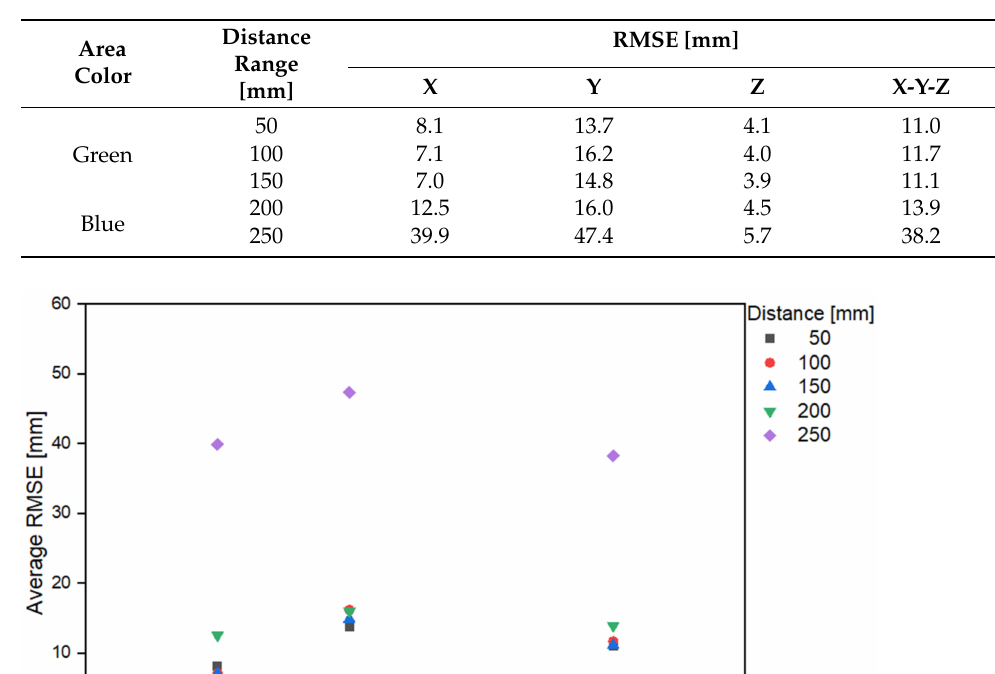
Table 4. RMSE based on the X-Y distance.